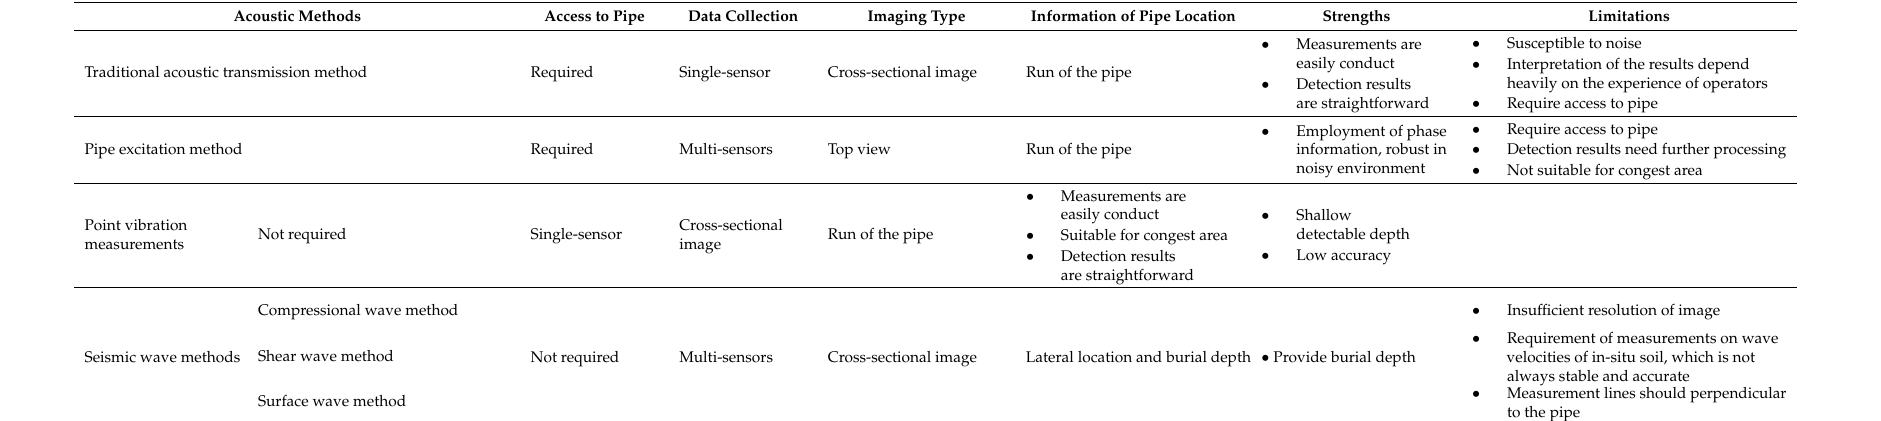
Table 3. Summary of di ff erent acoustic